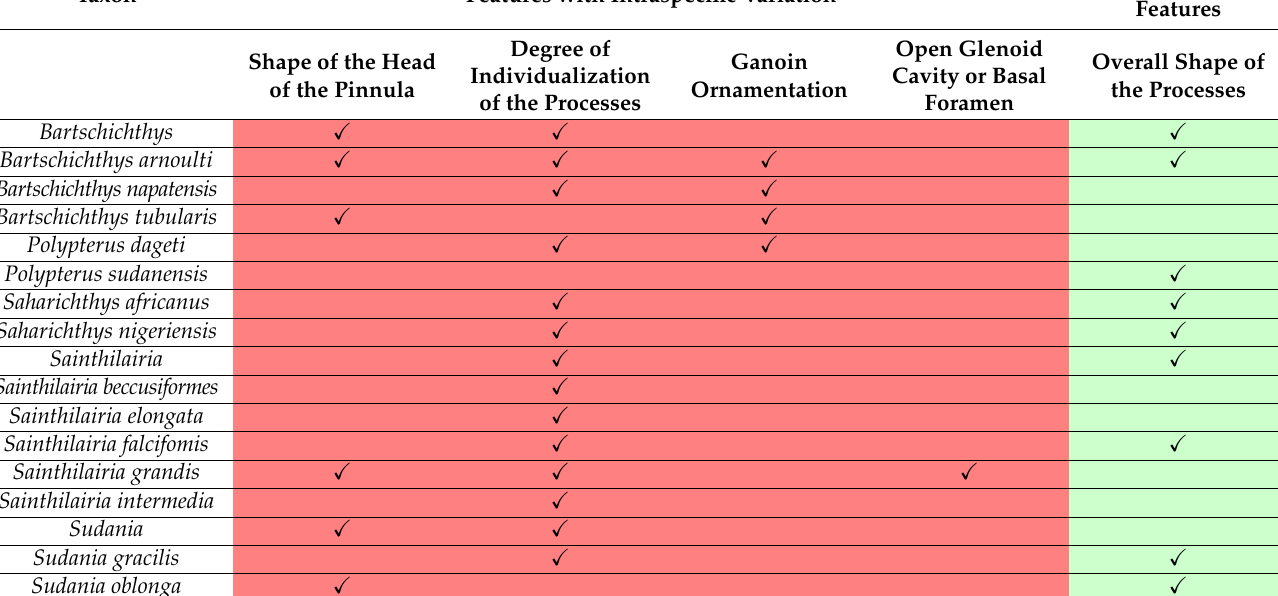
Table 1. A summary of the diagnostic features for nominal fossil taxa described based on symmetrical pinnule morphology and their variability are evaluated in this study for the extant species P . bichir . Red represents characters that have been shown to vary intraspecifically. Green represents characters that might be relevant in distinguishing